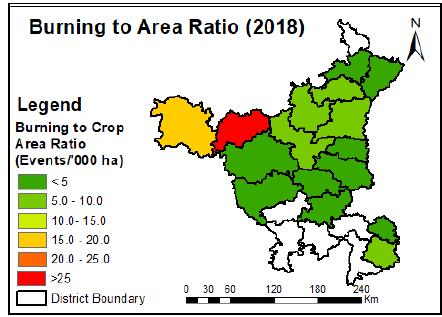
Figure 10. Burning events to crop area ratio in